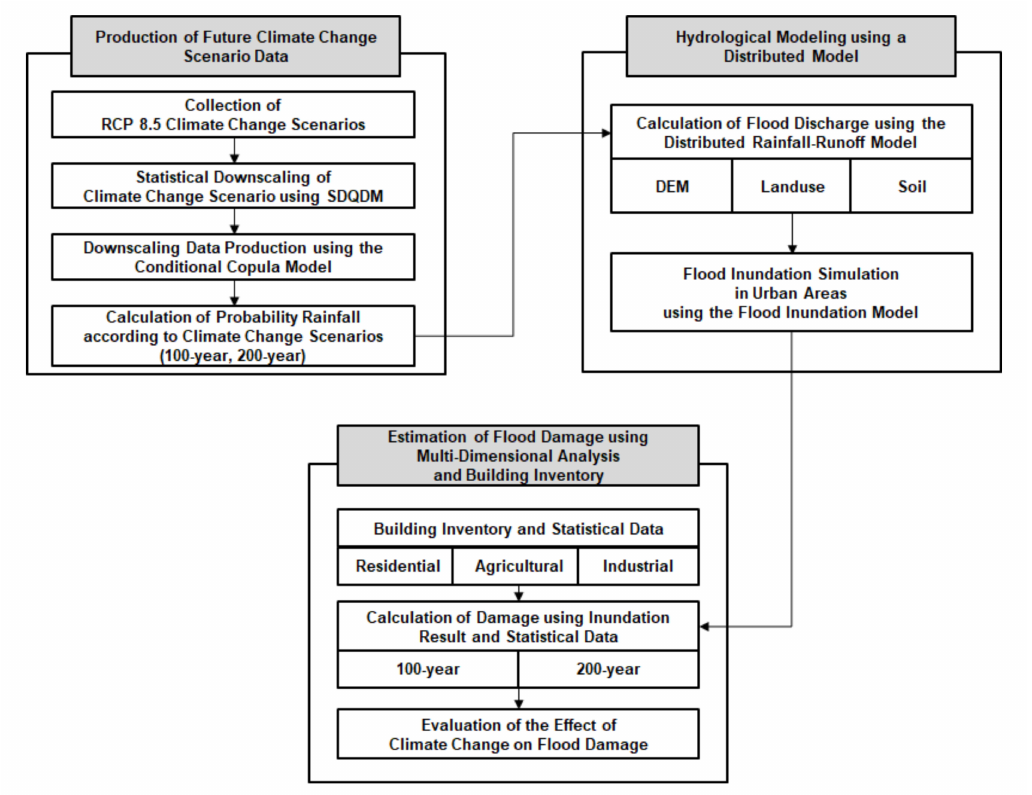
Figure 1. Flow Chart of